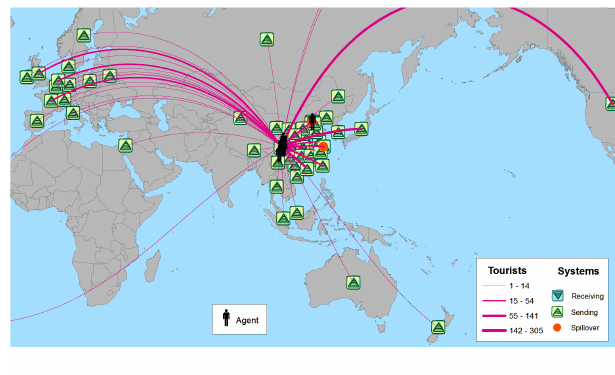
Fig. 10 . Systems, agents, and flows of tourists involved in the tourism case study for the Wolong Nature Reserve,